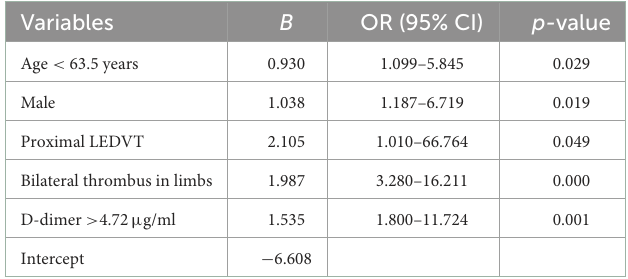
TABLE 2 Multivariable Model to Predict